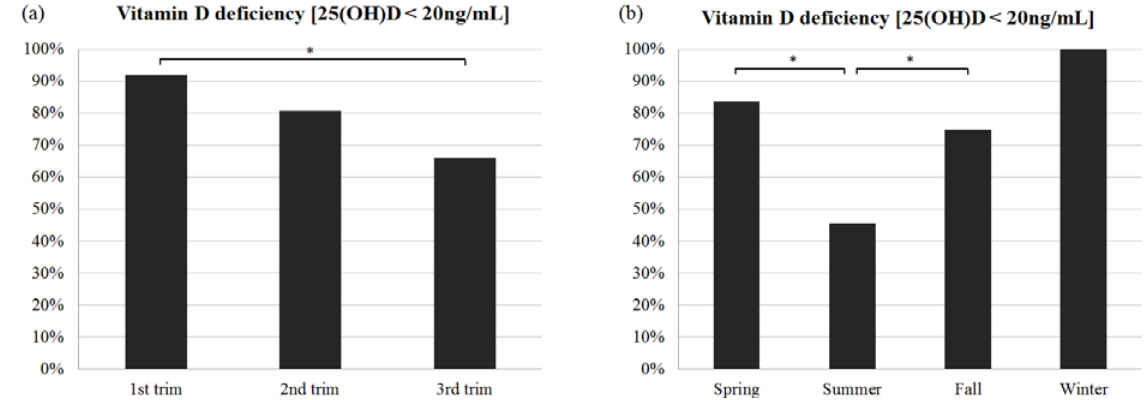
Figure 2. Prevalence of vitamin D deficiency (25(OH)D < 20 ng/mL) according to